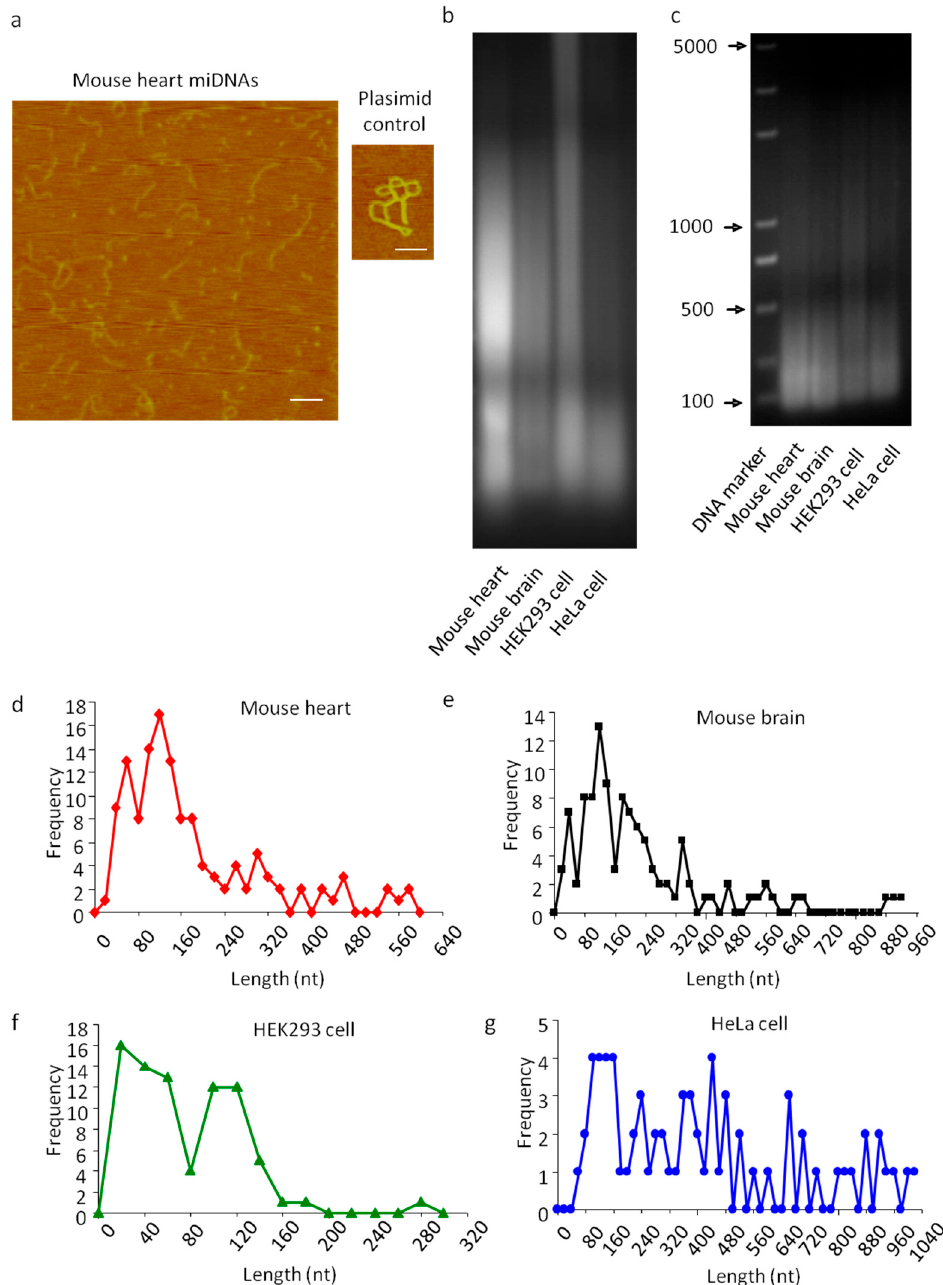
Figure 2. Identification of single-stranded linear extrachromosomal microDNAs. ( a ) Analysis of mouse heart nucleic single-stranded extrachromosomal DNA by atomic force microscopy. A 2982 bp double-stranded plasmid was used as a control. Bar = 200 nm. ( b ) Analysis of single-stranded extrachromosomal DNA by agarose electrophoresis. ( c ) Library amplification of single-stranded extrachromosomal DNA from mouse hearts (MHSSLmicroDNA), mouse brains (MBSSLmicroDNA), HeLaSSLmicroDNA and 293SSLmicroDNA, respectively. d-g, Analysis of the length distribution of SSLmicroDNAs from mouse hearts ( d ), mouse brain ( e ), HEK293 cells ( f ) and HeLa cells ( g ),